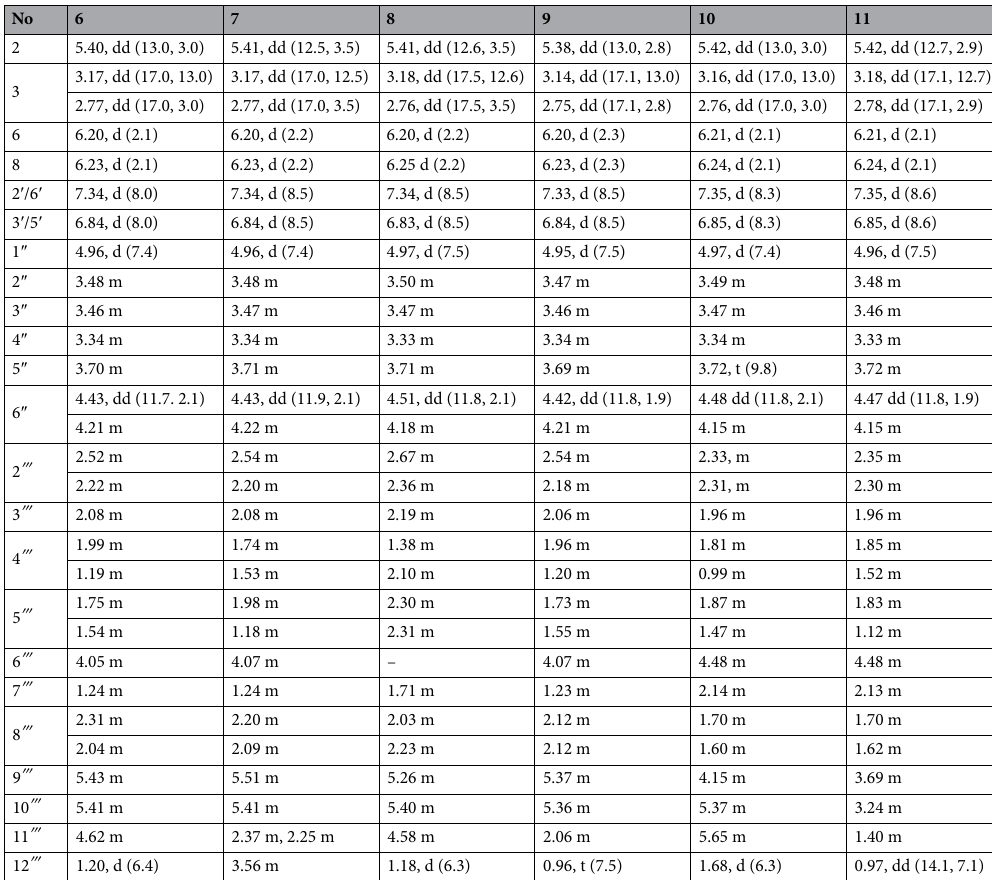
Table 2. 1 H NMR spectroscopic data for compounds 6–11 (CD 3